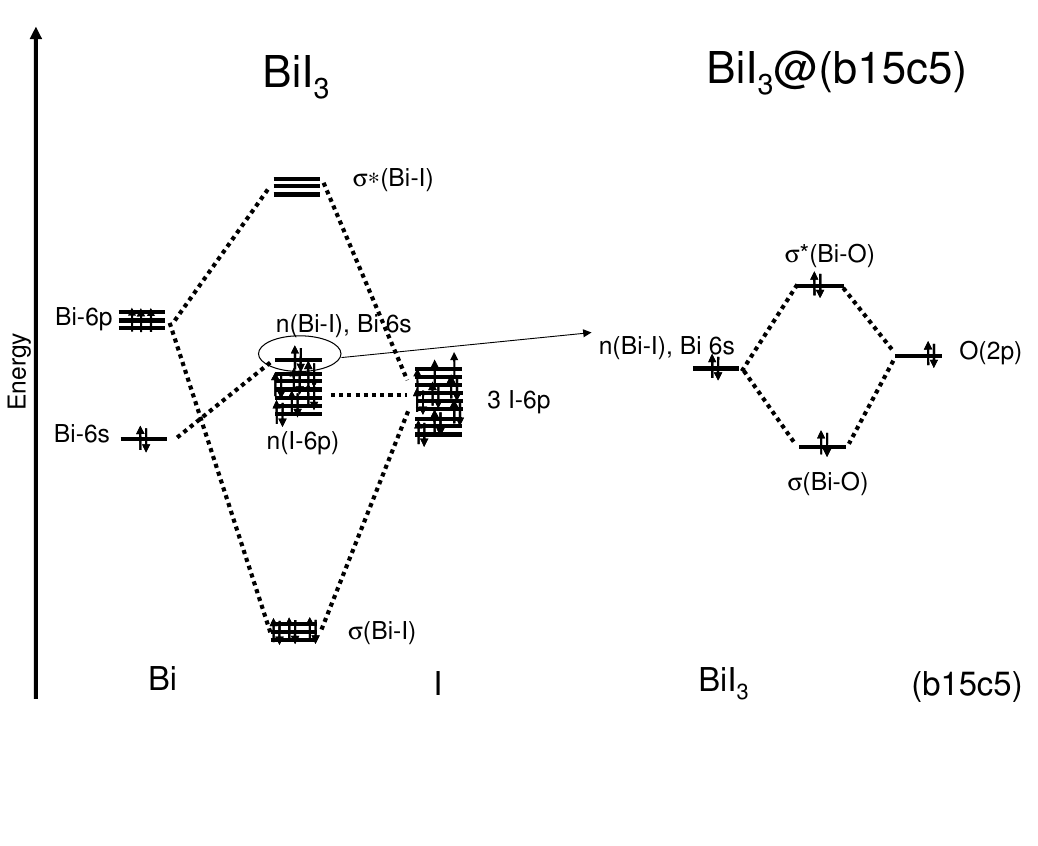
Figure 6. Schematic energy diagram describing the interaction between Bi 3+ and I - in BiI (left) and the relevant frontier orbitals of BiI (B15c5)BiI 3